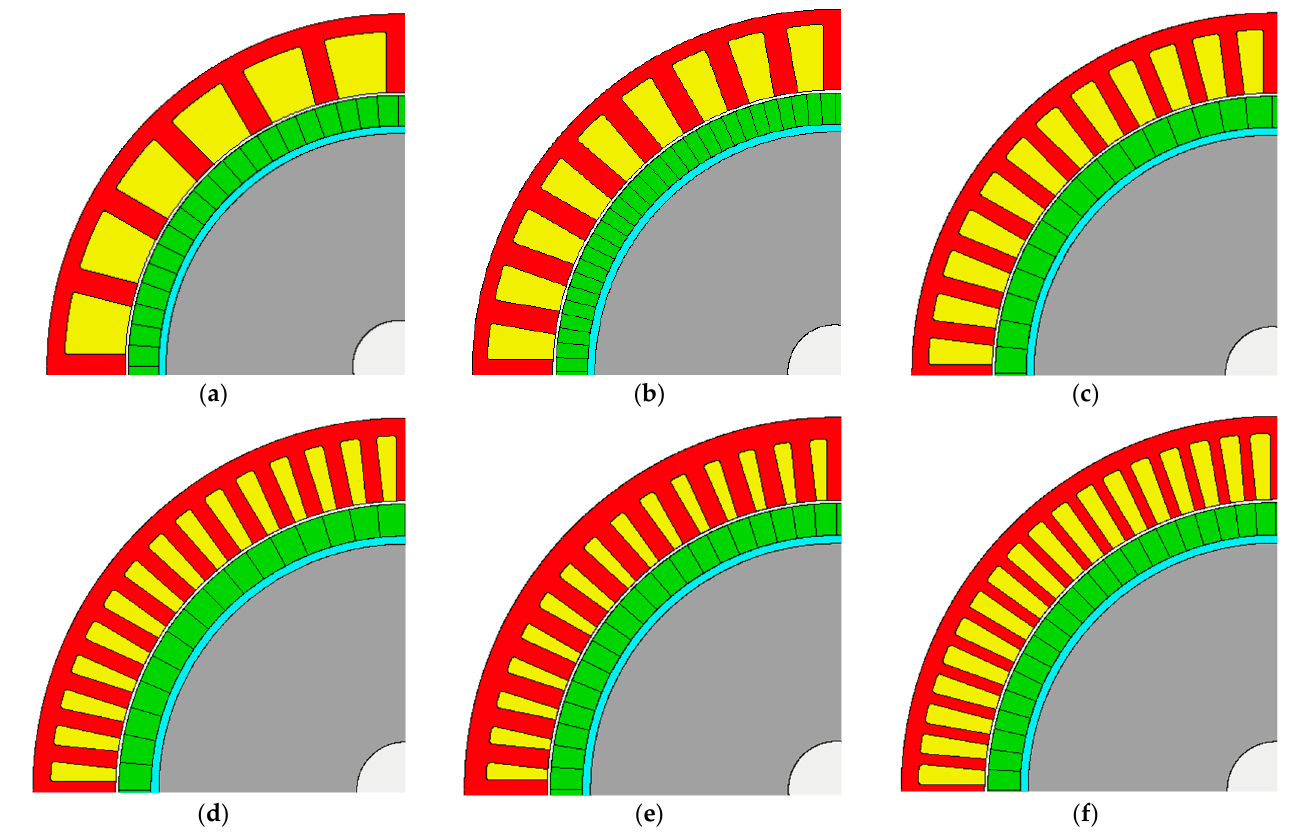
Figure 1. Schematic showing a radial sectioned view through a quadrant of the proposed motors, ( a ) S24-P20, ( b ) S36-P30, ( c ) S48-P16, ( d ) S60-P16, ( e ) S60-P20, and ( f ) S72-P22.